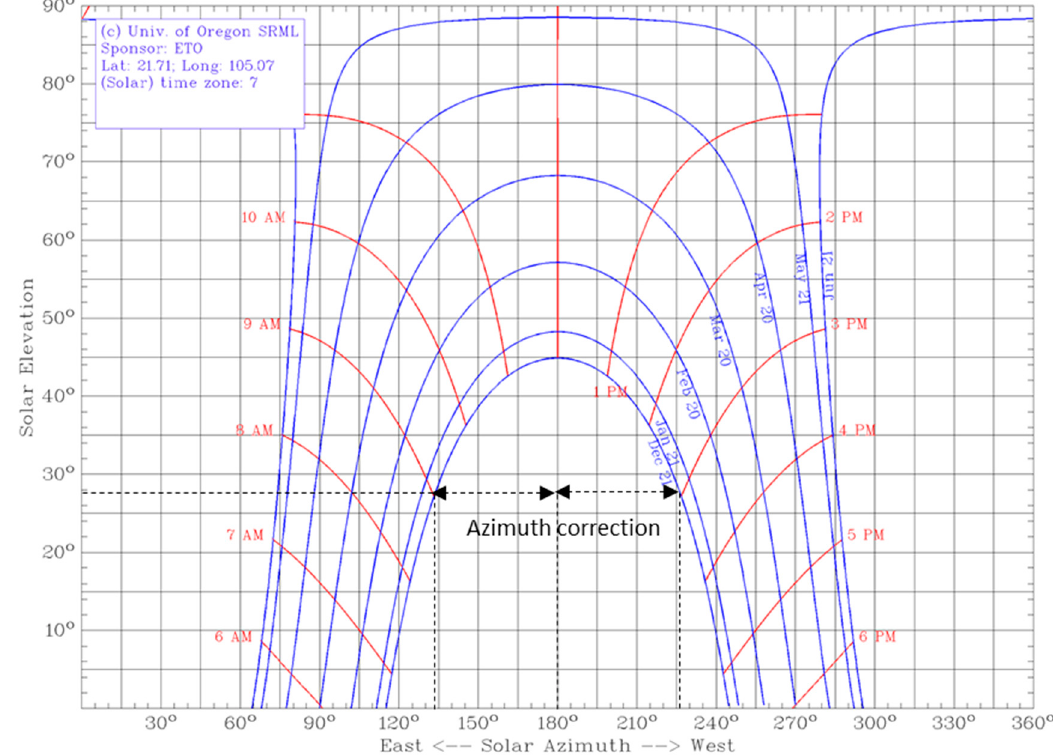
Figure 4. Example of the Cartesian plot of the sun path chart for North Vietnam. Adapted with permission from the Solar Radiation Monitoring Laboratory, University of Oregon, 2015.